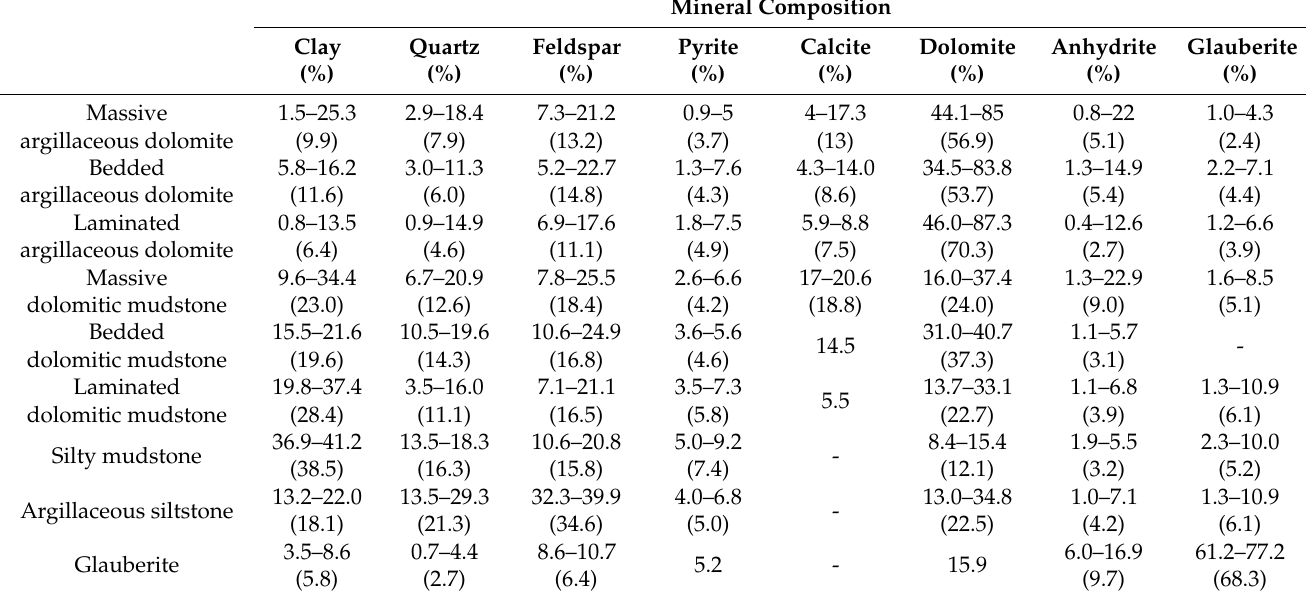
Figure 5. Ternary diagram of the lower member of the Xingouzui Formation. Table 2. Mineral contents of different lithofacies.